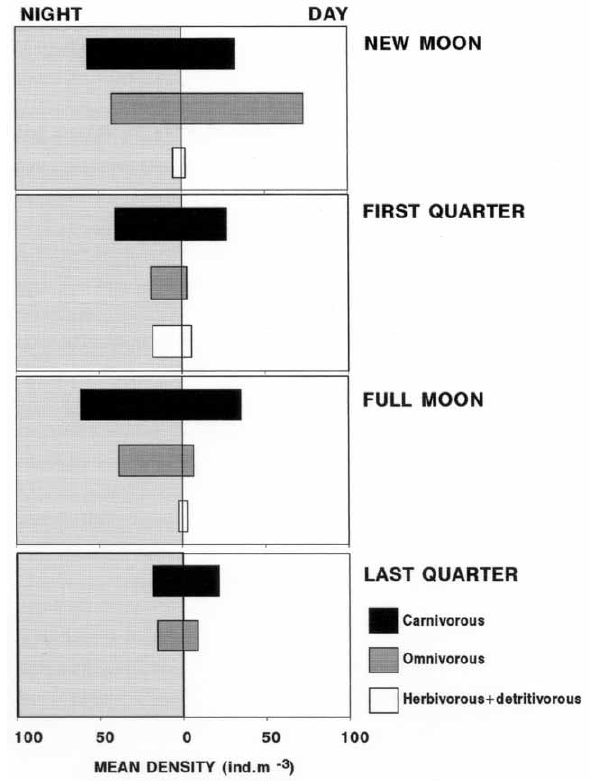
F IG . 7. – Mean density of zooplankton trophic levels, during the phases of the moon, in the day and night periods, at the three depths. Concentrations (ind. m -3 ) are represented by horizontal bars. Shaded area: